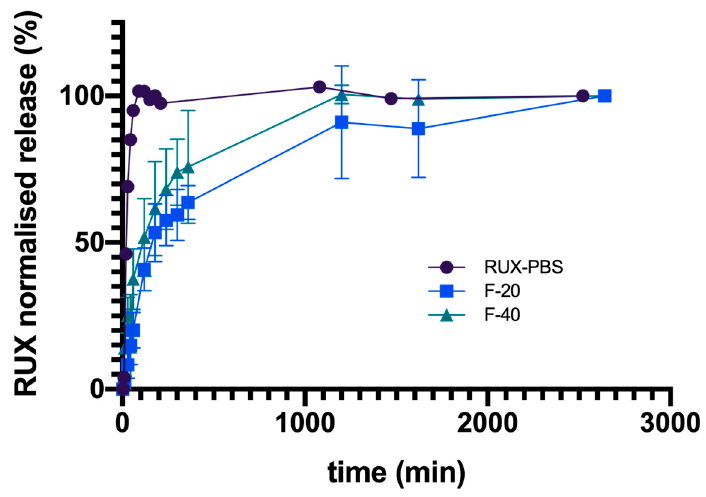
Figure 7. RUX normalized average cumulative transmembrane diffusion. Legend: F-20 samples contain 20 mg fibrinogen; F-40 samples contain 40 mg fibrinogen; PBS sample contains only RUX in PBS (see Table 1).